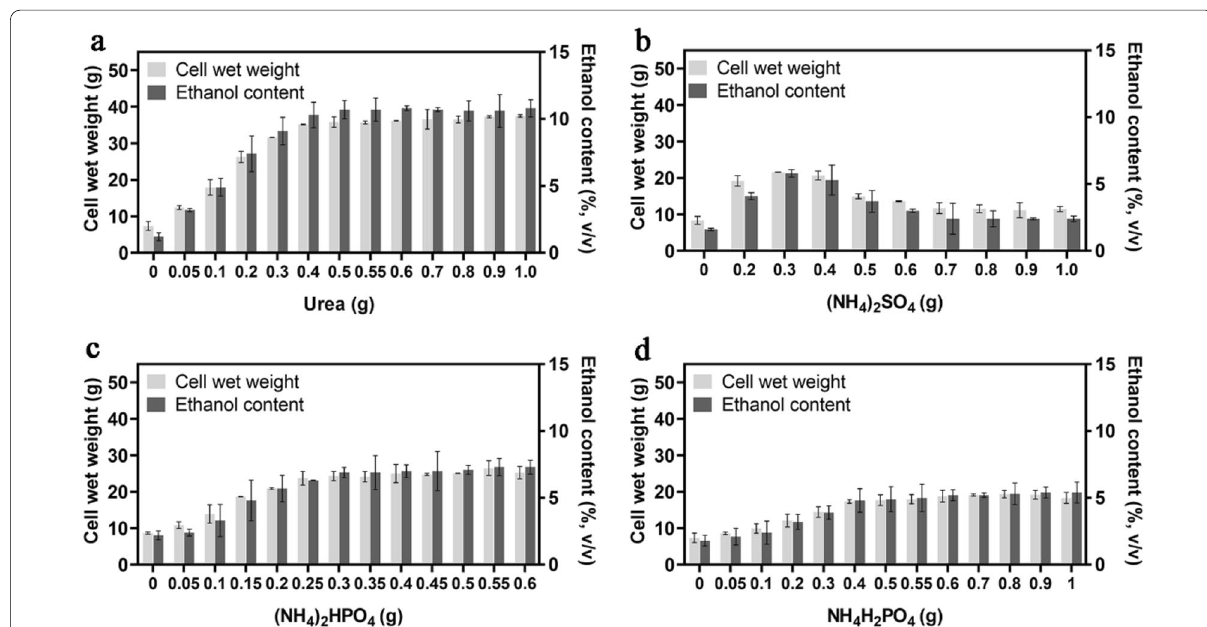
Fig. 4 Effect of the nitrogen and phosphorous source on the cell wet weight and ethanol content of glucoamylase expressing strain CIBTS1522. The influence of the nitrogen source urea ( a ) and (NH 4 ) 2 SO 4 ( b ). The influence of the compound inorganic nitrogen and phosphorous sources (NH 4 ) 2 HPO 4 ( c ) and NH 4 H 2 PO 4 ( d ) on these parameters. Error bars represent the standard deviation from the mean of three